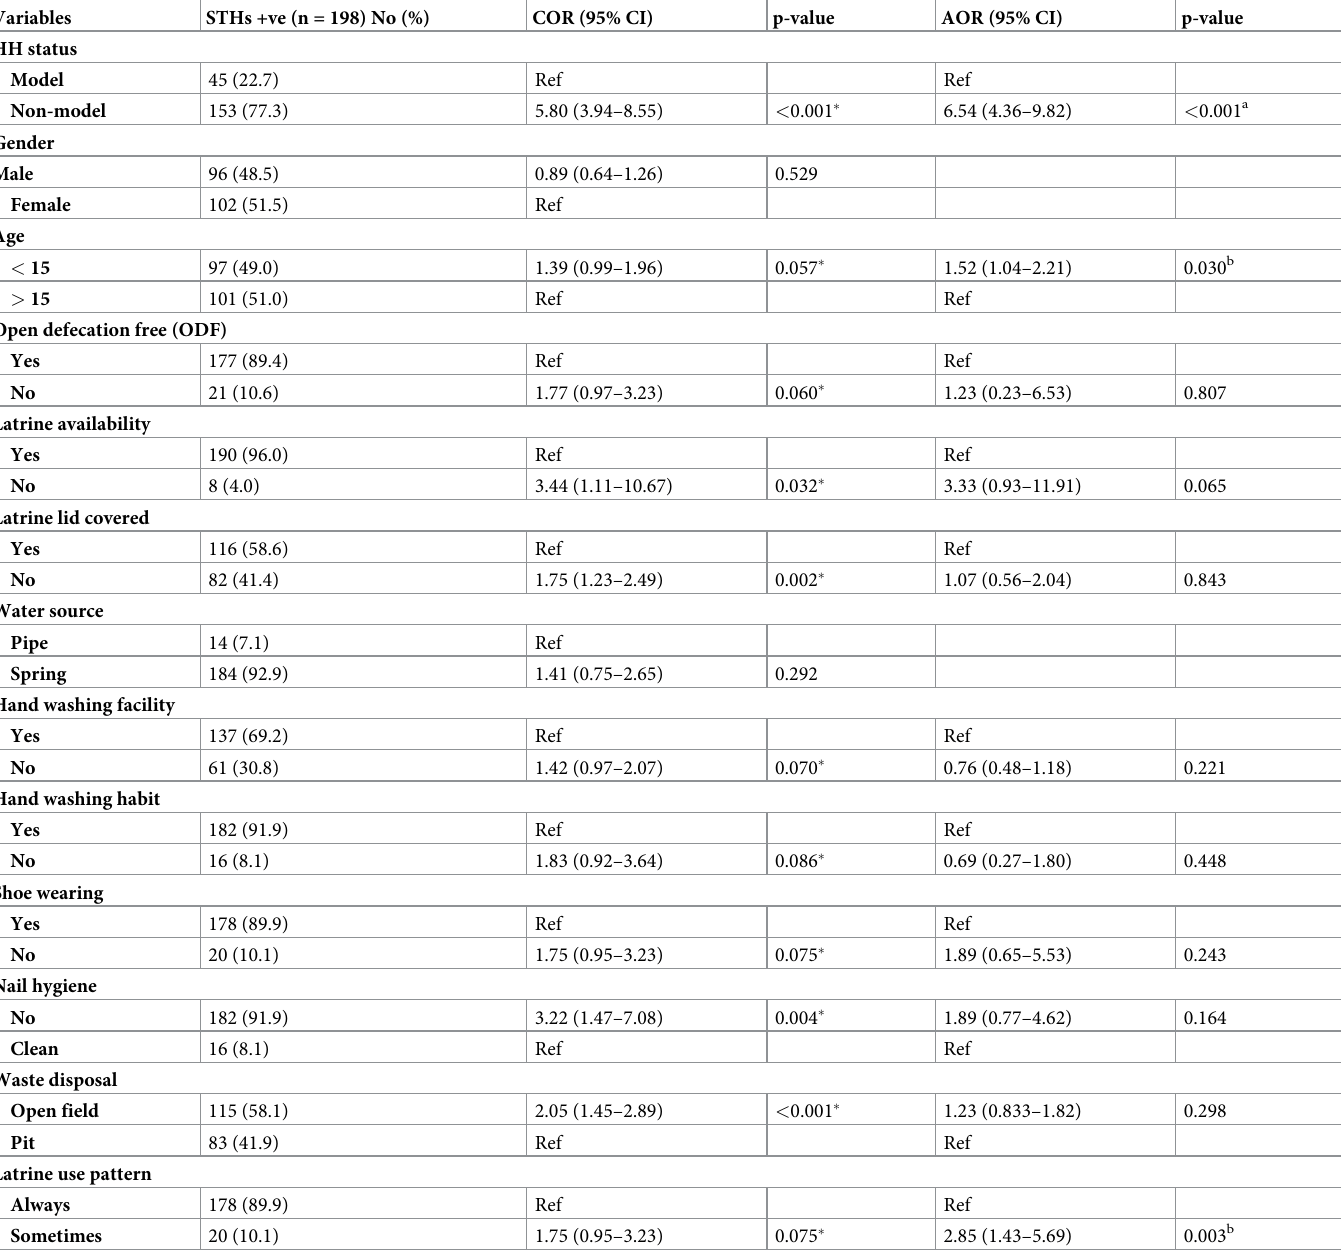
Table 3. Bivariate and multivariate logistic regression of risk factors of STHs infection among individuals in model and non-model HHs, Seka Chekorsa woreda, Jimma zone, Southwest